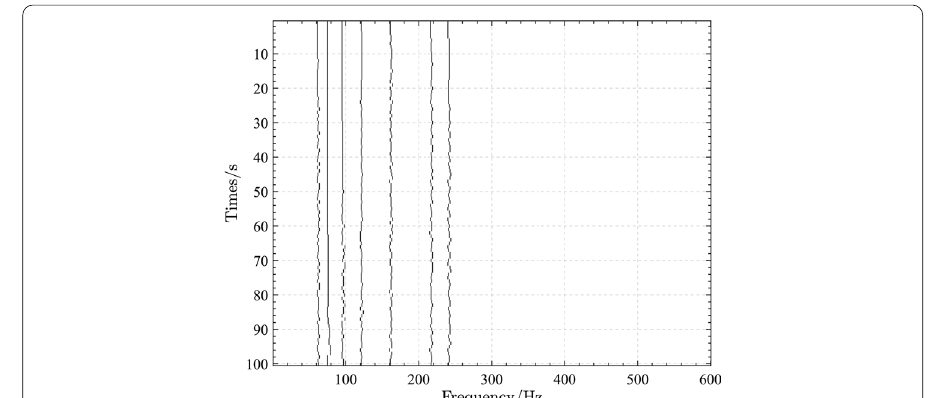
Fig. 20 Extraction results of optimal path algorithm of second set of sea-trial data